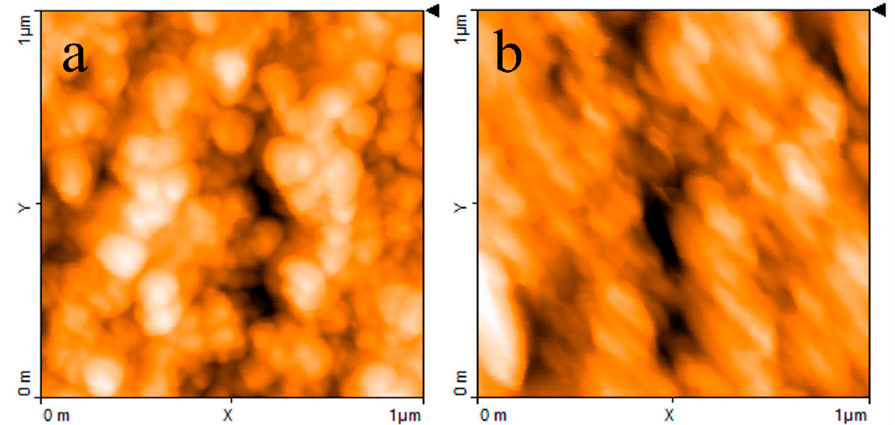
Figure 5. ( a ) Detailed AFM view of the sample imaged in Figure 4b and ( b ) of the sample imaged in Figure 4c.